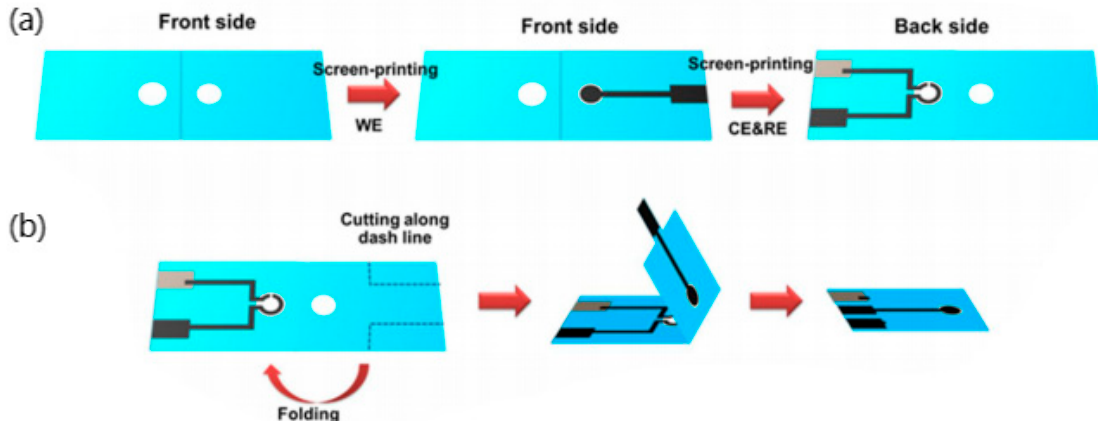
Figure 6. ( a ) Fabrication procedure of label-free paper-based impedance immunosensor for human interferon-gamma (IFN- γ ), ( b ) 3D folding sequence [86] .